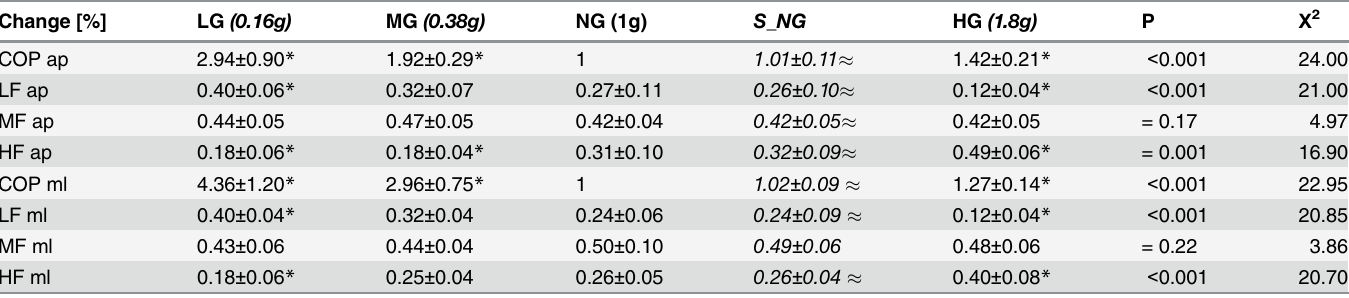
Table 1. Averaged values of all participants for COP ap and COP ml and the COP frequency distribution (LF 0.15 – 0.5Hz, MF 0.5-2Hz and HF 2-6Hz ex- pressed as a percentage of TSE) for the gravity conditions below (Lunar (LG) and Martian (MG)) and above (hypergravity (HG)) normal gravity (NG).